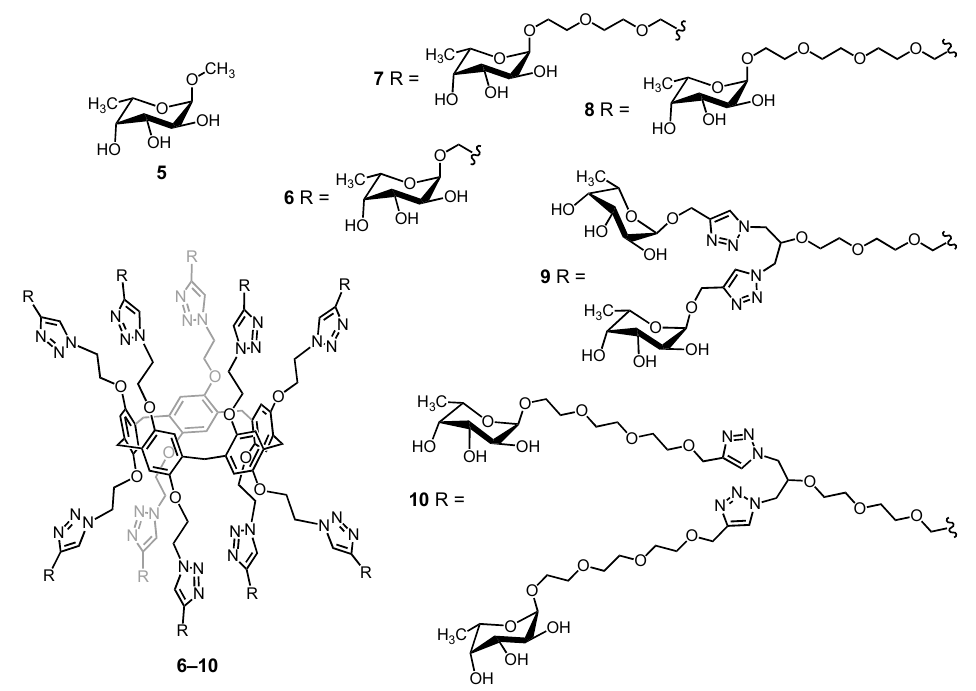
Figure 5. Model monovalent ligand 5 and glycopillar[5]arenes with 10 and 20 peripheral fucose subunits (MW: 3323.31 ( 6 ); 4204.41 ( 7 ); 4644.94 ( 8 ); 8028.18 ( 9 ); 10671.86 ( 10 )). Table 1. Isothermal titration microcalorimetry data for the interactions of glycopillar[5]arenes with LecB and RSL.